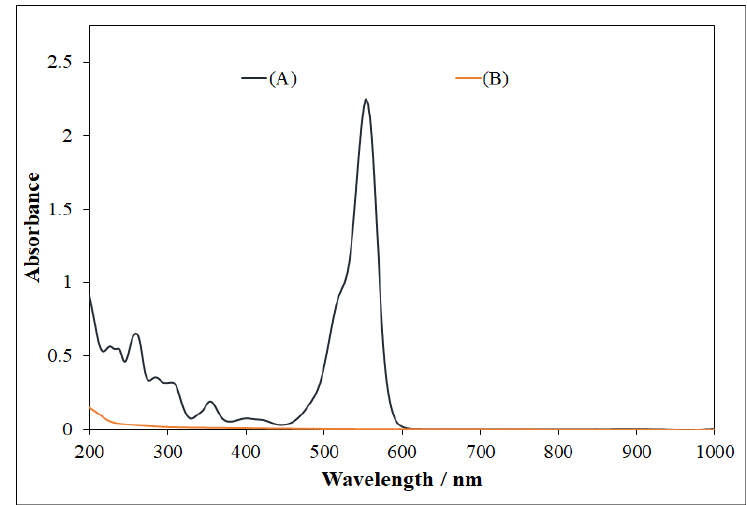
Figure 12. ( A ) Rhodamine B spectrum, and ( B ) UV-visible spectrum obtained after MB degradation using NP-3 (Cu II0.4 Fe II0.6 Fe III2 O 4 ). Experimental conditions: concentration of NPs = 400 mg/L, concentration of H 2 O 2 = 1.76 × 10 −1 mol/L, concentration of RhB = 1.75 × 10 −5 mol/L, initial pH = 7.5, and irradiation time = 140 min.